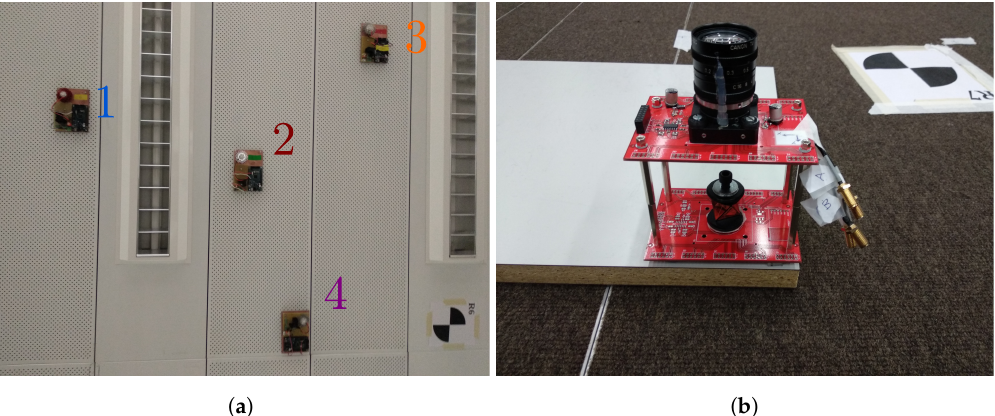
Figure 5. ( a ) Emitters used for the experimental evaluation as placed. View of their placement on the lab ceiling. ( b ) Receiver (PSD and lens system) and reference mini